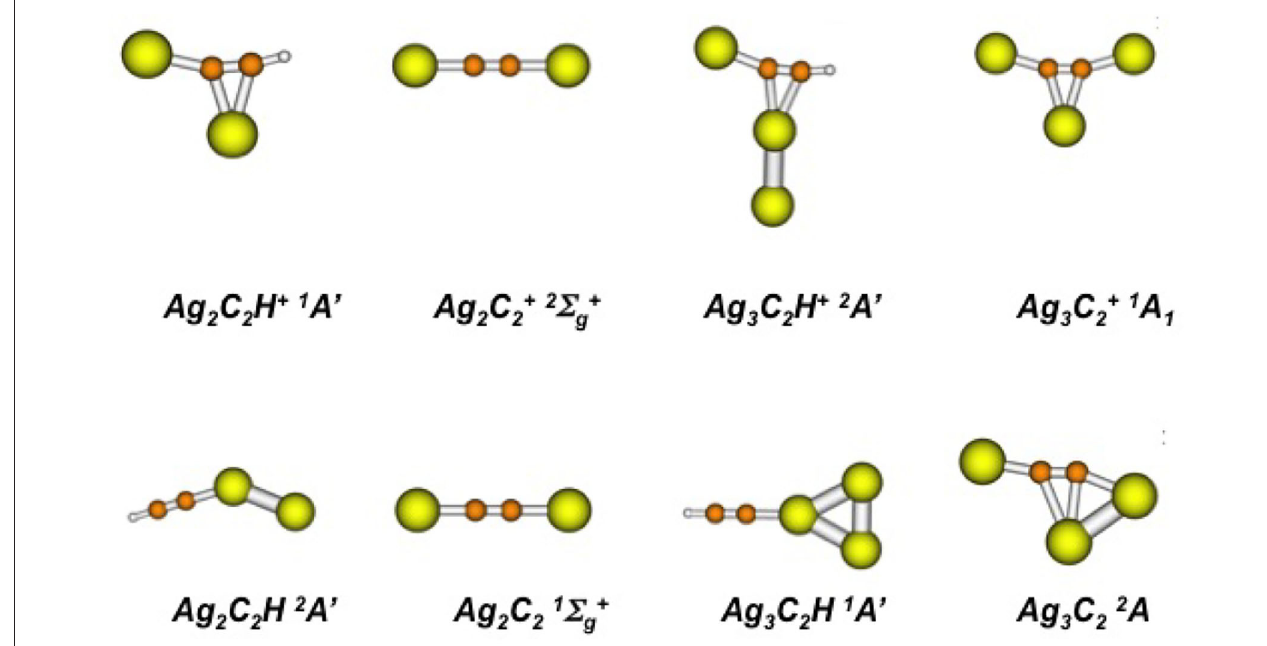
FIGURE 7 | Lowest energy structures and electronic states for [Ag 2,3 C 2 ] 0 / + and [Ag 2,3 C 2 H] 0 / + calculated using DFT.